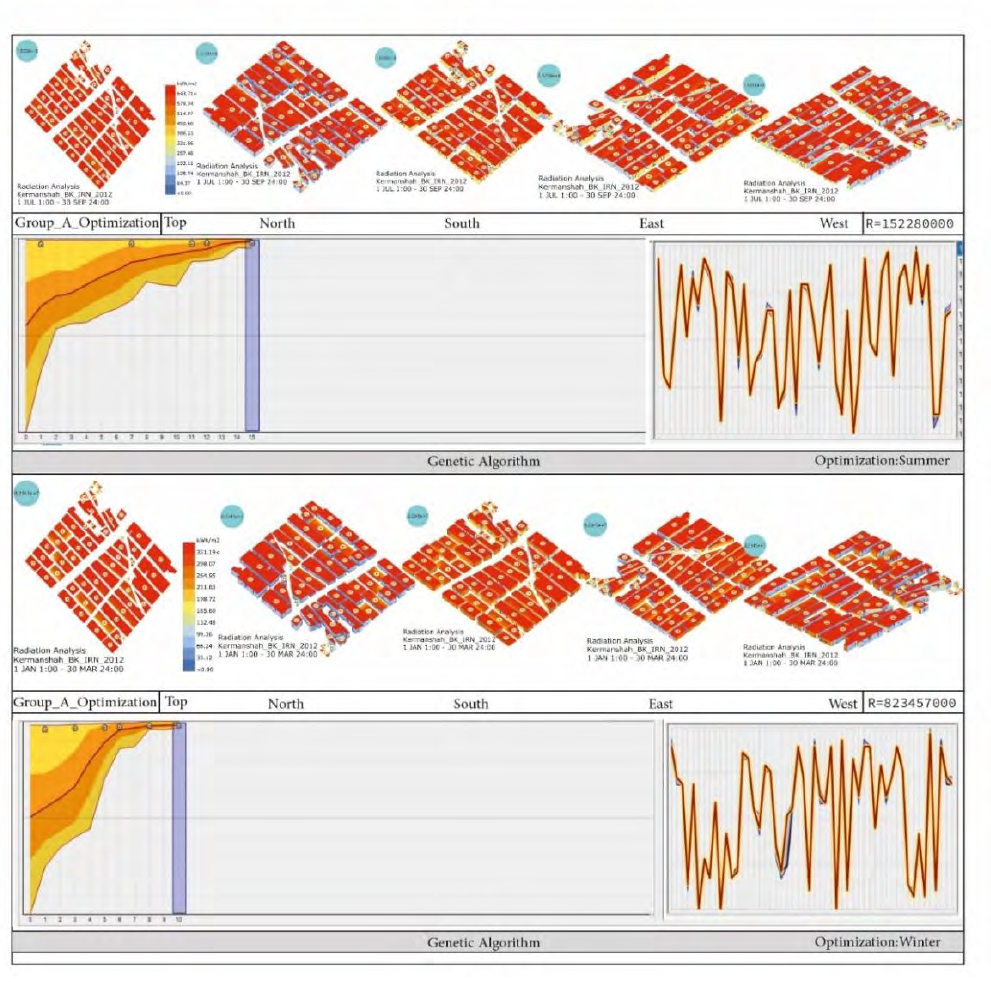
Figure 14 - Optimization of urban block variables in winter and summer in group A.